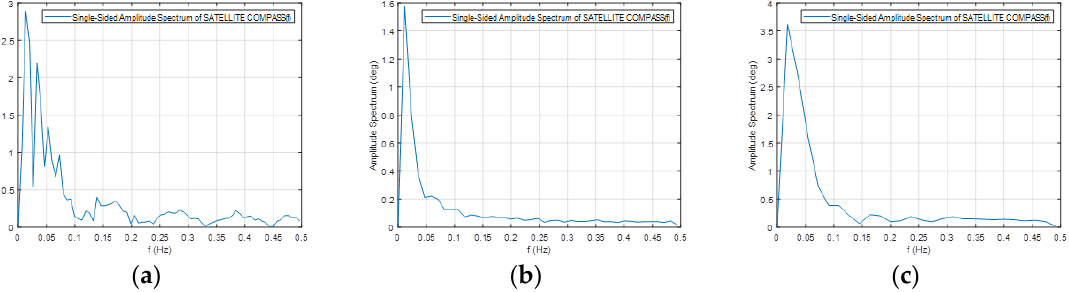
Figure 14. Frequency spectrum for the Furuno compass raw heading records in Figure 12 for the speeds of 10 km/h ( a ), 20 km/h ( b ) and 30 km/h ( c ).